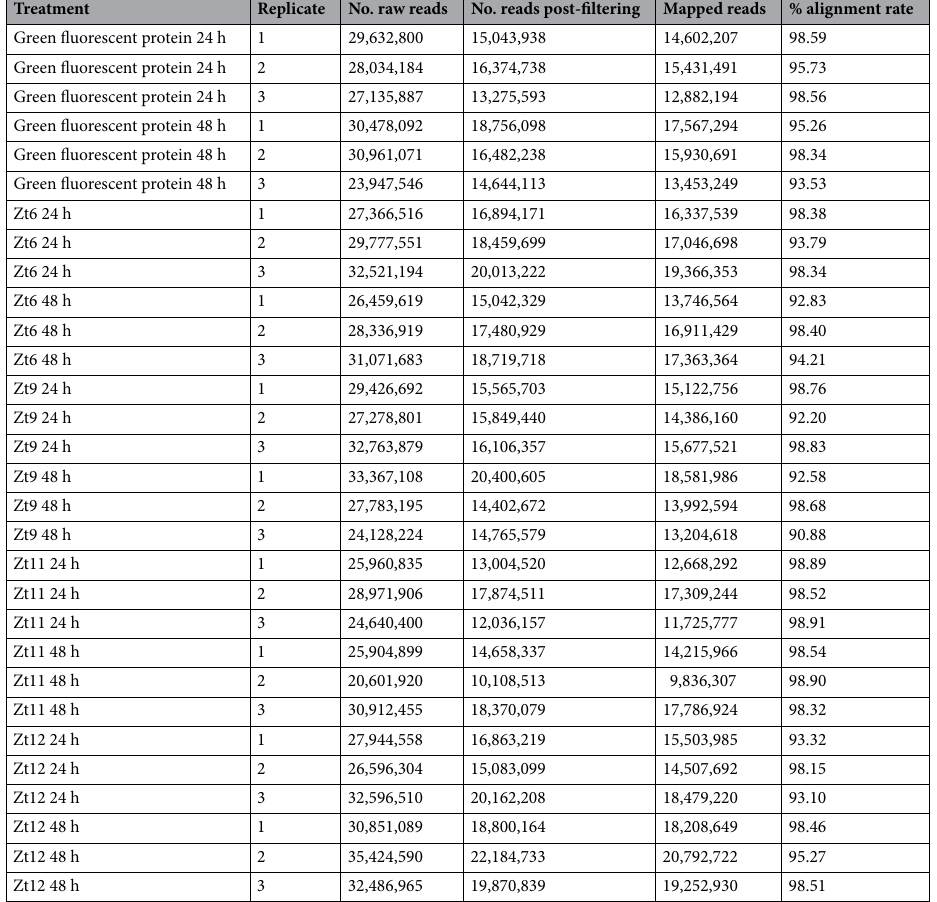
Table 1. Overview of the RNA-seq data collected for each treatment.